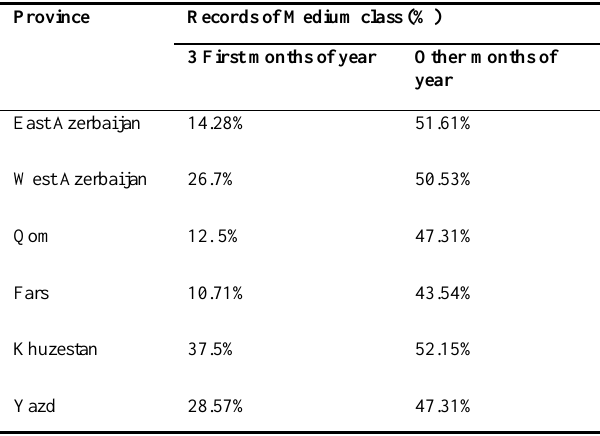
Table 11. Comparison between spring and rest of year's transactions.